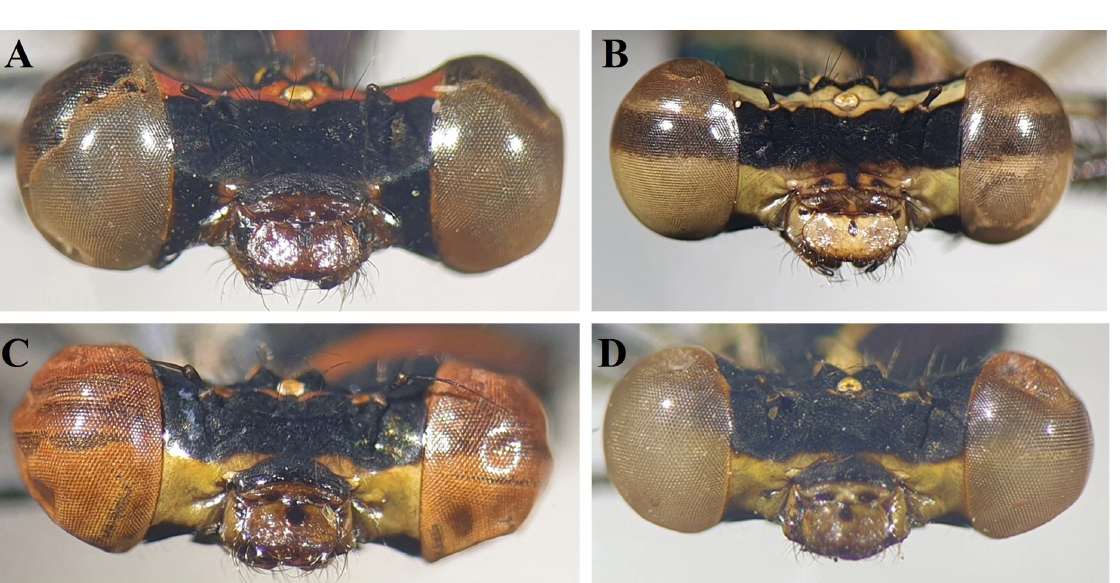
Fig. 12. Head of Prodasineura Cowley, 1934 spp., frontal view. A–B . P. kong sp. nov. A. ♂, holotype, ZCDTU 2019071811-ODO. B. ♀, paratype, ZCDTU 2019071817-ODO. C–D . P. lancastrei sp. nov. C. holotype, ZCDTU 2019051212-ODO. D. ♀, paratype, ZCDTU 2019051217-ODO. Images not